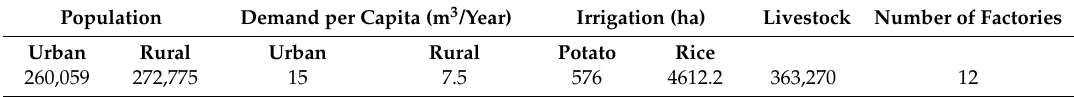
Table 1. Statistics information on current situation (2013).